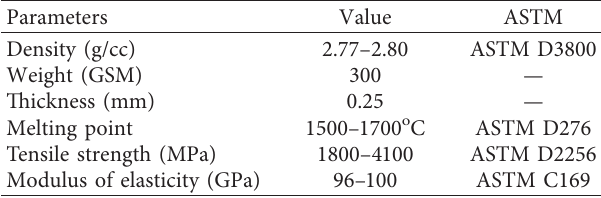
Table 1: The basic properties of basalt fabrics used.